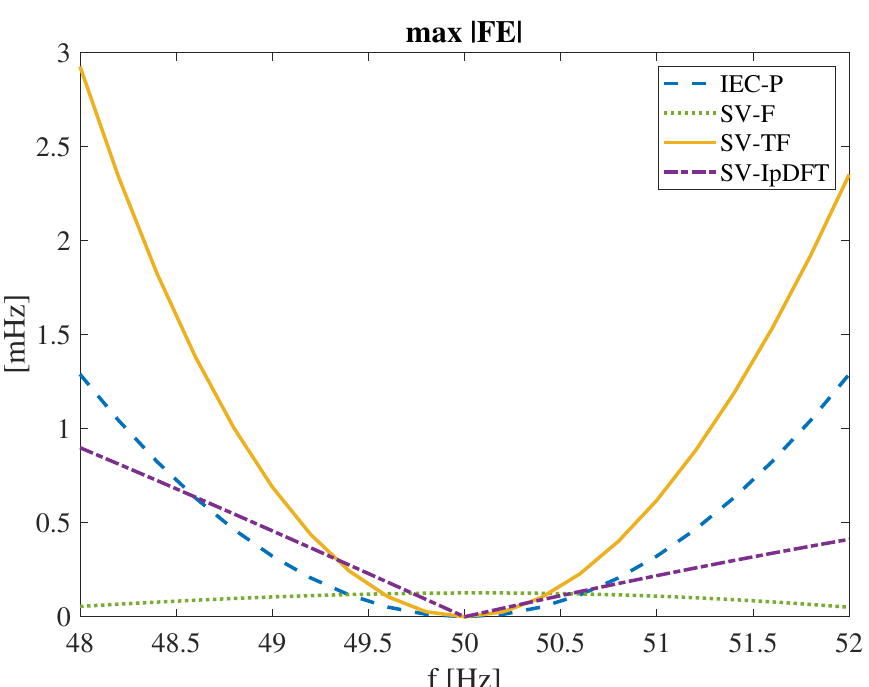
Figure 9. Maximum |FE| results under off-nominal frequency conditions in the presence of magni- tude unbalance.